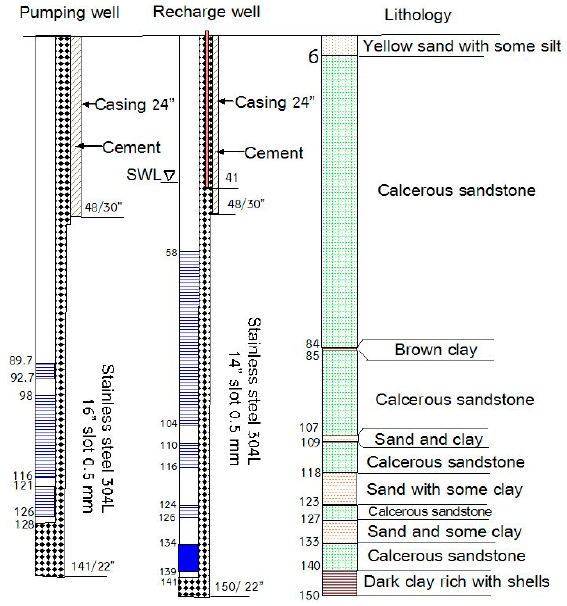
Figure 3. Technical and geological profile of the pumping and recharge well on the pilot site.